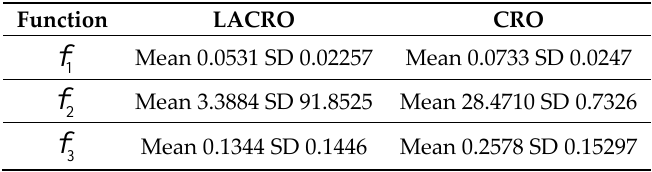
Table 1. Results on three functions based on 10 independent